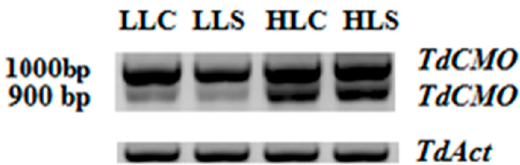
Figure 1. Reverse transcription polymerase chain reaction (RT-PCR)-amplified putative choline monooxygenase ( TdCMO ) genes. LLC, cDNA from low light control leaves; LLS, cDNA from low light salt-stressed leaves; HLC, cDNA from high light control leaves; HLS, cDNA from high light salt-stressed leaves. Weight size marker are indicated on the left and the name of the PCR product on the right.